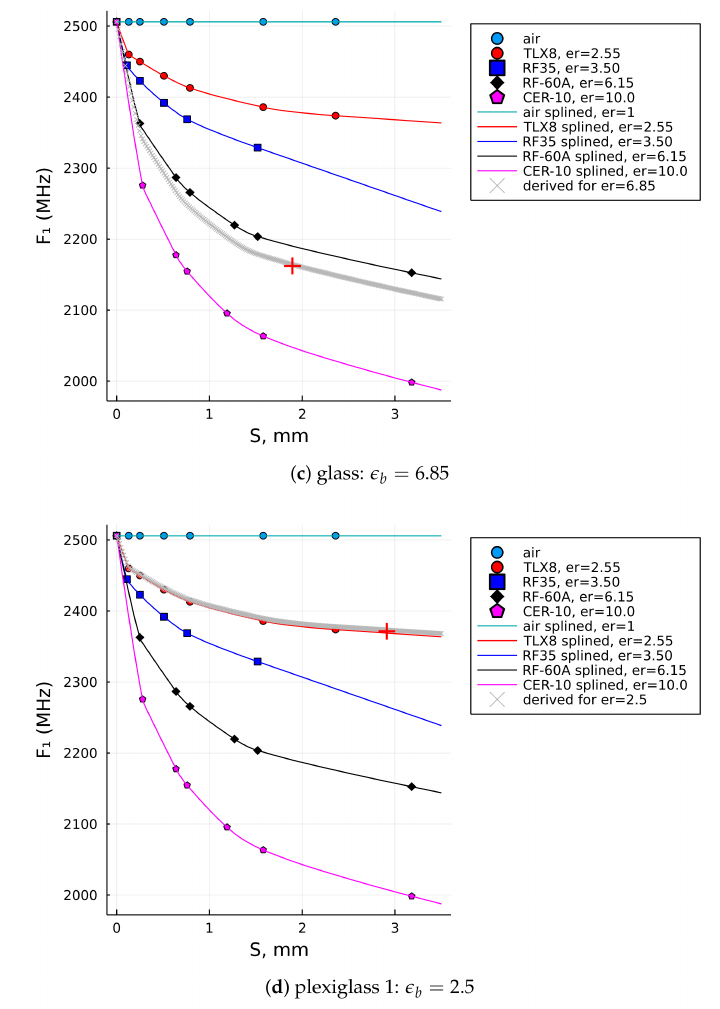
Figure 6. SUT permittivities computed by the proposed algorithm ( a ) for the RF60A-0300 laminate, ( b ) for the FR4 laminate, ( c ) for glass, and ( d ) for plexiglass